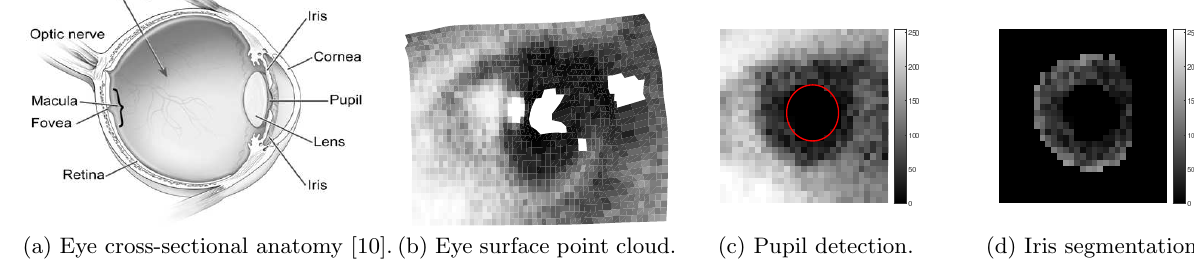
Figure 1: Eye surface imaged by the RealSense